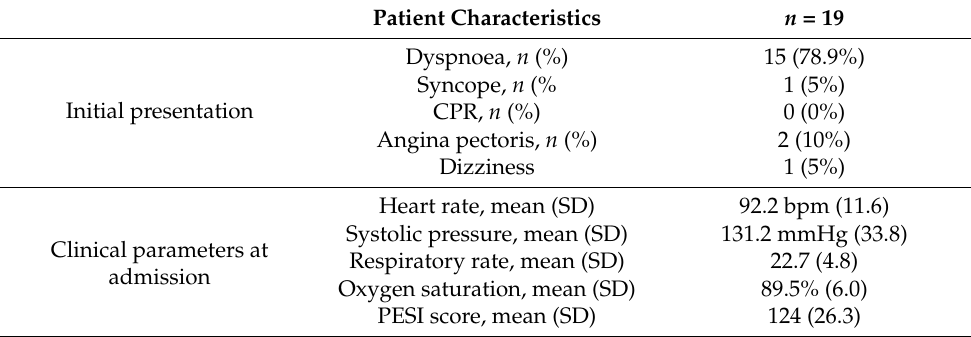
Table 2. Clinical, chemical laboratory, and echocardiographic parameters at admission. CPR: car- diopulmonary resuscitation, RVEDd: right ventricle end-diastolic diameter, LVEDd: left ventricle end-diastolic diameter, sPAP: pulmonary artery pressure, TAPSE: tricuspid annular plane systolic excursion, SD: standard deviation, PESI: pulmonary embolism severity